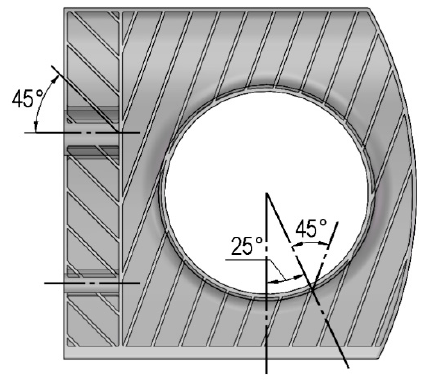
Figure 12. Reinforced filling structure.